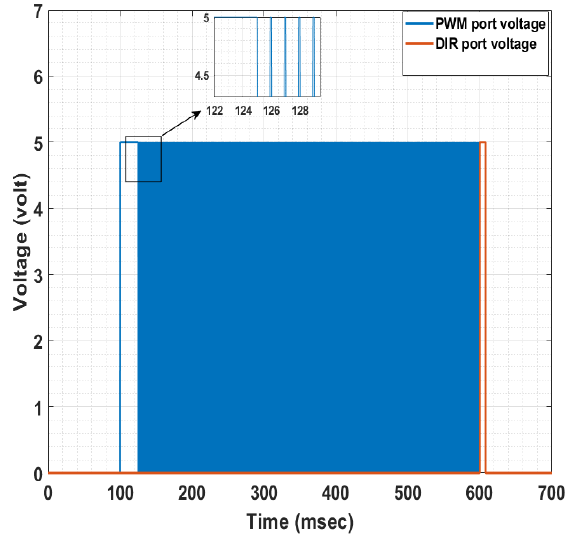
Figure 112. The driver card control ports voltage according to the proposed control code.